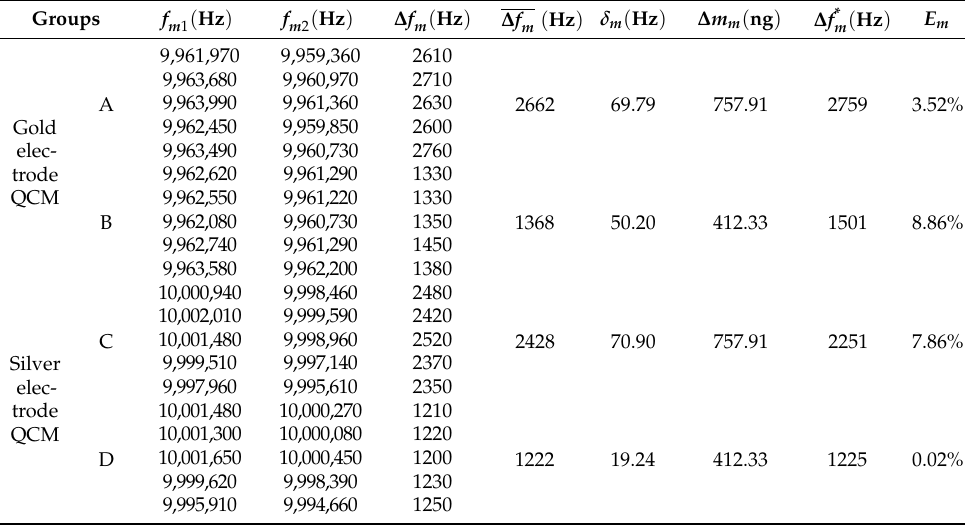
Table 3. Experimental results on the effect of different electrode materials on the mass sensitivity of QCM